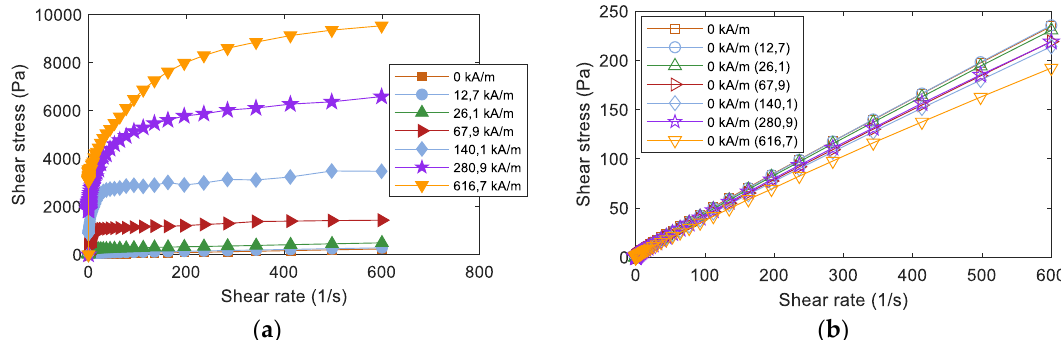
Figure 2. ( a ) Obtained rheological curves as a function of the applied magnetic field; ( b ) Reversibility of the rheological curves after applying a magnetic field and subsequent demagnetizing process. Measurements shown correspond to the nominal fluid FeCo-MRF-OA-MS.